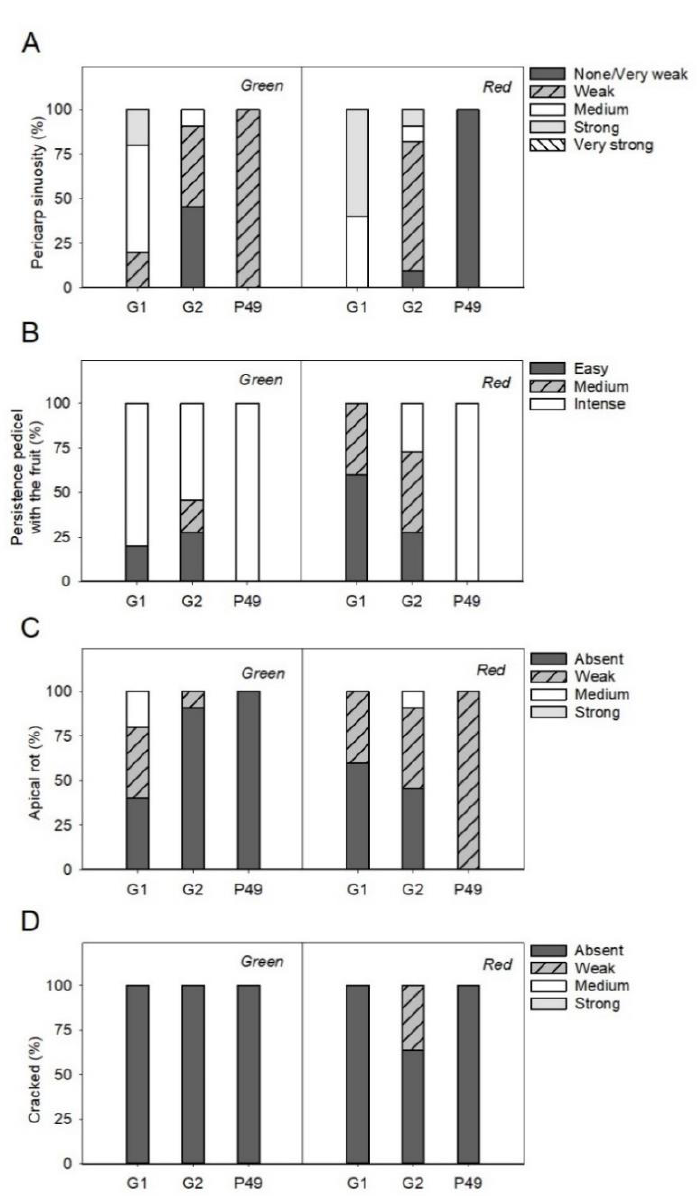
Figure 7. Frequency distribution of the selected fruit qualitative traits in the 17 pepper landraces in two ripening stages (green and red); ( A ) pericarp sinuosity, ( B ) persistence pedicel with fruit, ( C ) apical rot, ( D ) cracked. The mean value for each landrace was represented by the most frequent representation of the trait after classifying the independent fruit samples ( n = 10) according to the scale (Table S1).